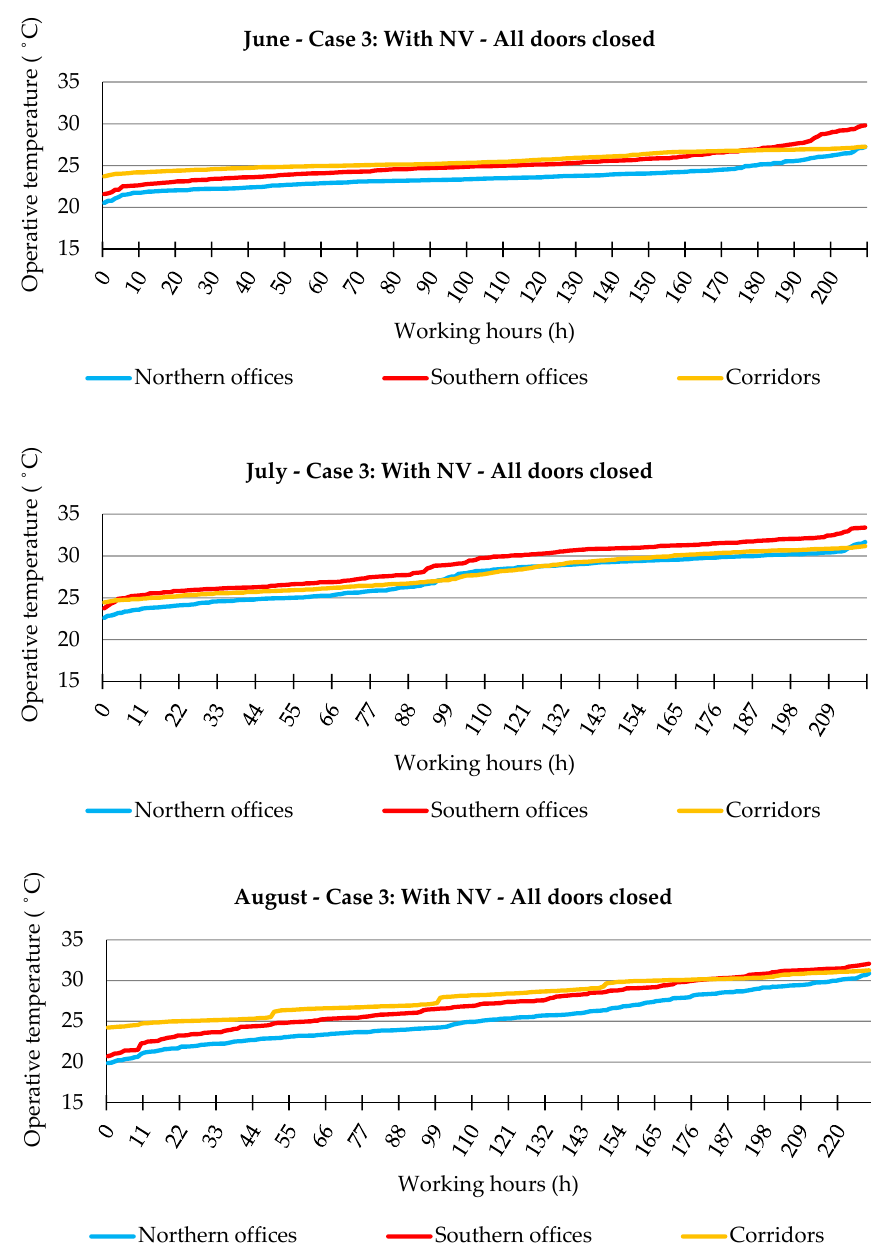
Figure 6. The average operative temperatures of the northern and southern offices and the corridors for the case with NV with all doors always closed (case 3) during the hot summer of 2018. Southern offices represent offices with southeast orientation with higher internal solar gains compared to other offices. Northern offices represent all other offices excluding the open-plan office.